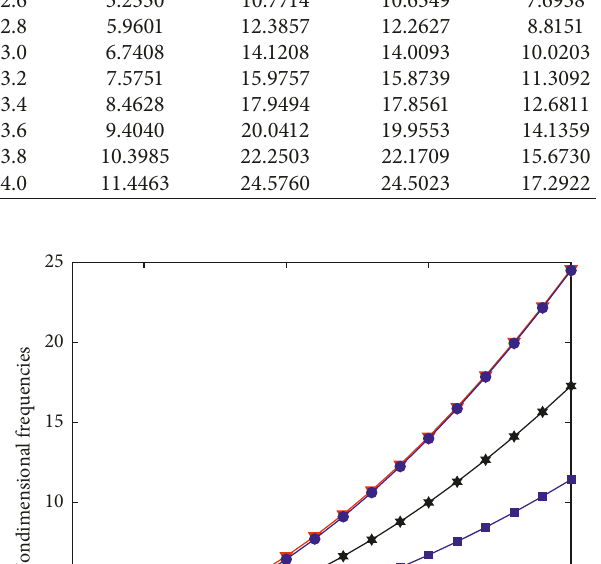
Figure 11: The effect of ratio h mental frequencies of the plate with a / b � 1 and k